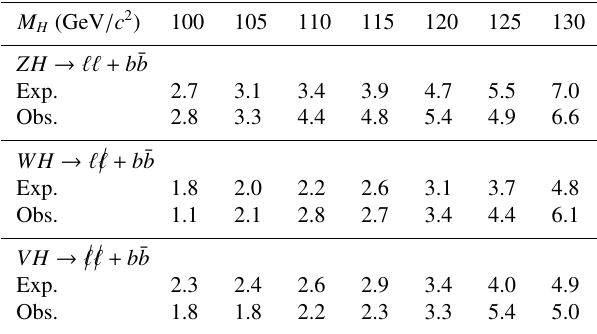
Table 1. Observed and expected 95% C.L. measured by the CDF experiment using a luminosity up to 7 . 8 fb − 1 for di ff erent SM Higgs boson masses in the primary search channels ( (cid:96)(cid:96) + b ¯ b ,